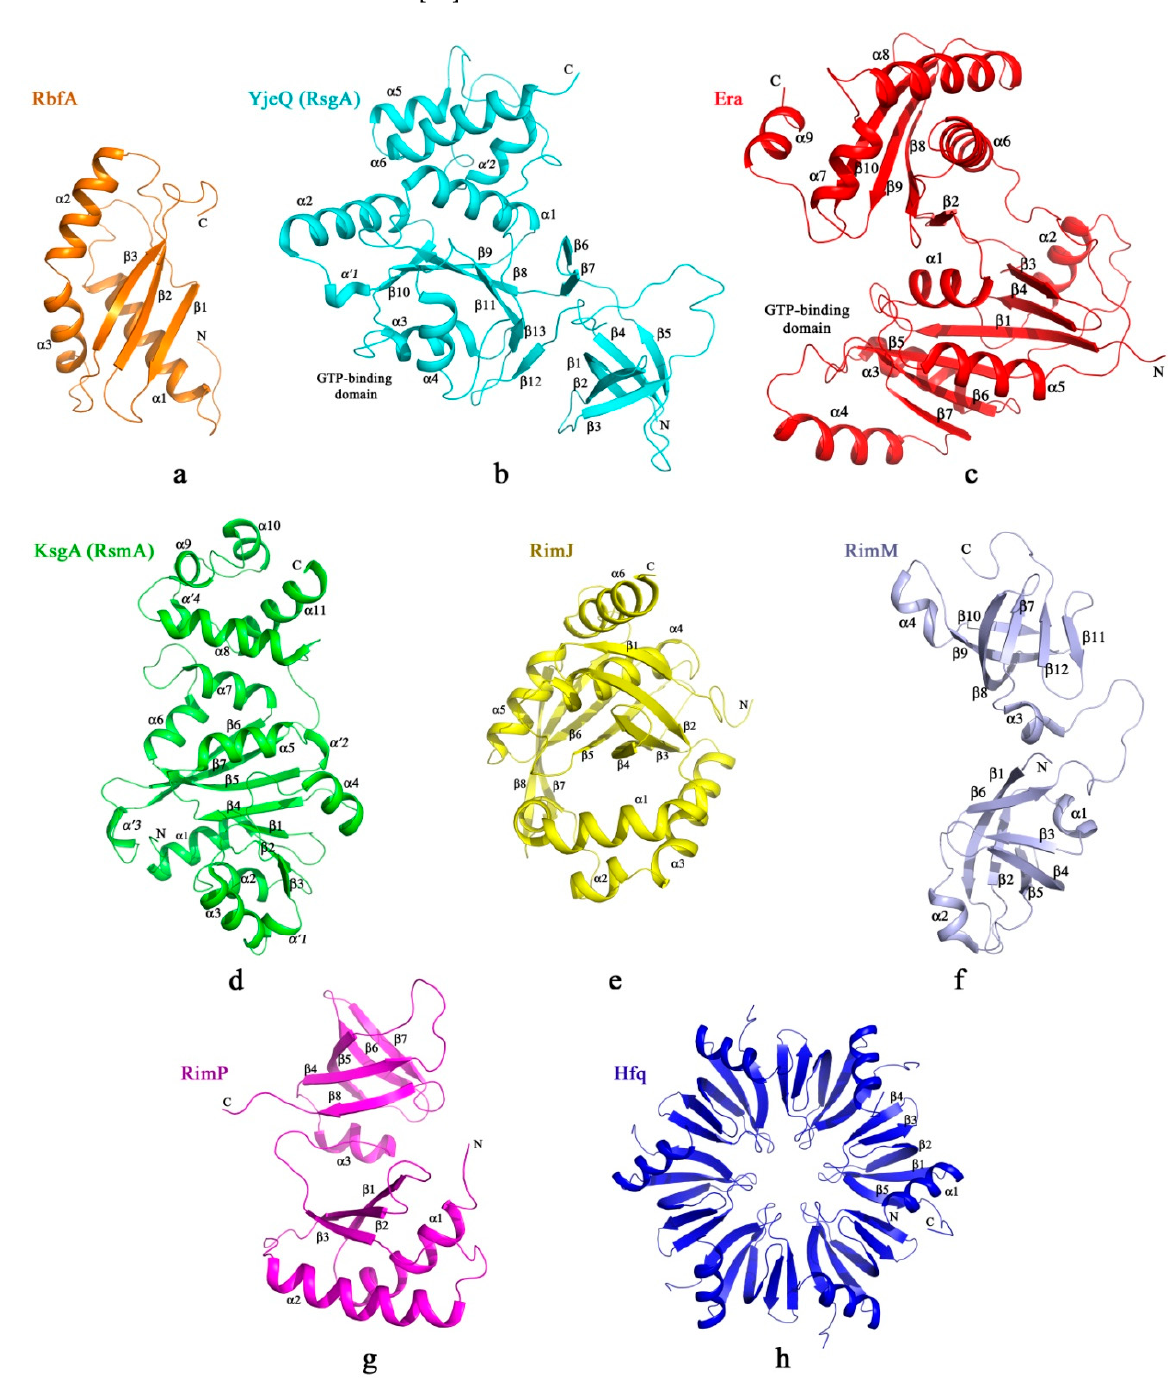
Figure 3. Domain organization of the 30S assembly factors. Secondary structure elements, α -helices ( α ), β -strands ( β ), and 3 10 helices ( α ’) are numbered according to their relative position in the polypeptide sequence. Crystal structures of: ( a ) RbfA (PDB ID: 1KKG); ( b ) YjeQ (RsgA) (PDB ID: 1U0L); ( c ) Era (PDB ID: 1EGA); ( d ) KsgA (RsmA) (PDB ID: 1QYR); ( e ) RimJ (PDB ID: 6C30); ( f ) RimM (PDB ID: 2DYI); ( g ) RimP (PDB ID: 7NAT); ( h ) Hfq (PDB ID: 1HK9).